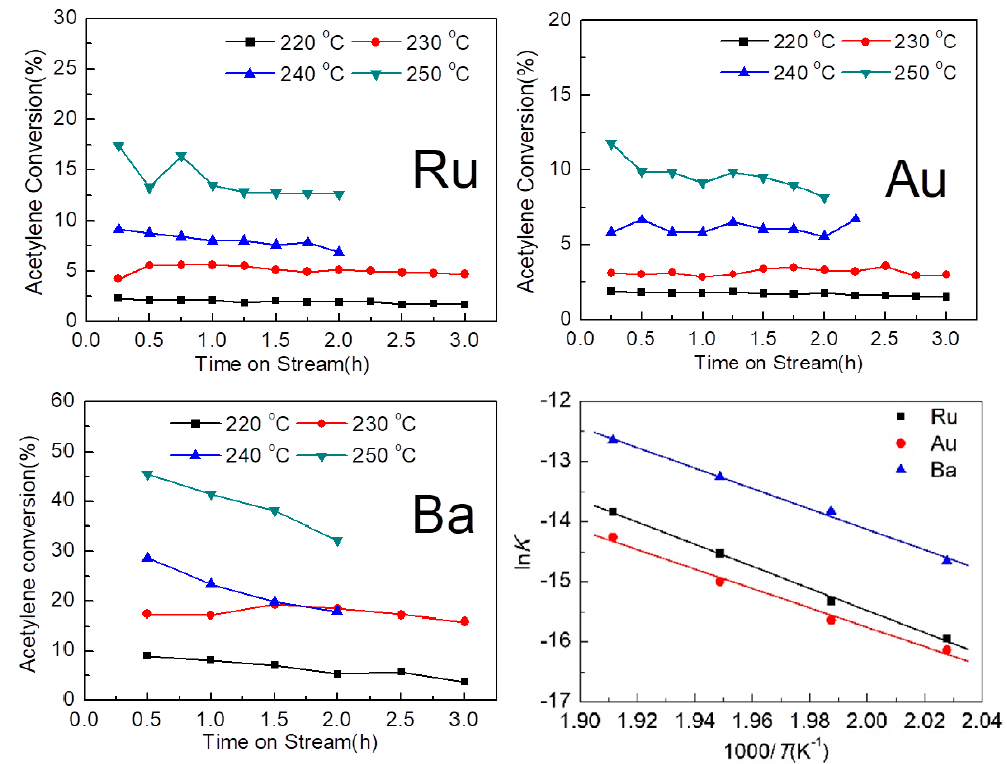
Figure 4. Experimental results of metal chloride catalysts for DCE-acetylene exchange reaction at 220, 230, 240 and 250 °C. Reaction conditions: GHSV = 90 h − 1 , V (C 2 H 2 )/ V (DCE) = 1:1.1. The slope of linear fitting was used to determine the experimental activation energies according to the Arrhenius equation.